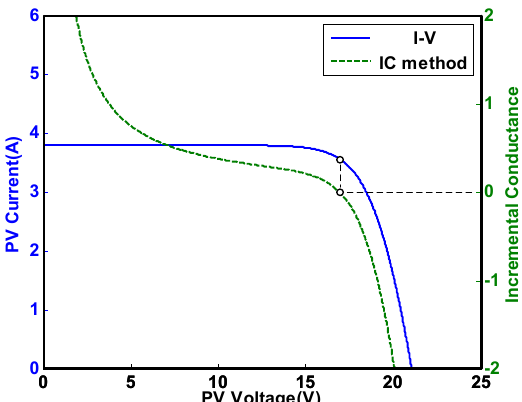
Figure 23. PV cell current-voltage and characteristics.